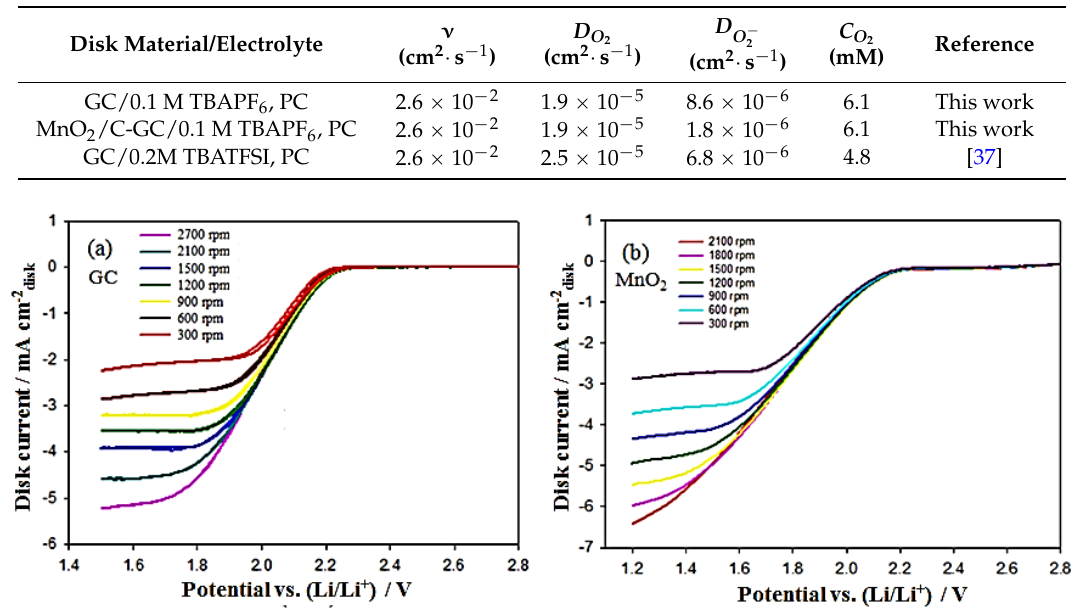
Figure 6. ( a ) Example of determination of the superoxide radical (O 2• − ) transit-time ( T s ) in O 2 -saturated solutions of 0.1 M TBAPF 6 in propylene carbonate (PC) at ω = 100 rpm, E disk = 1.85 V and E ring = 2.6 V. Transit time ( Ts ) values at different rotation rates for the diffusion of ( b ) O 2 and ( c ) O 2• − ; ( d ) relation between the inverse of the rotation speed and the transient time for O 2 and O 2• − . Table 1. Summary of the electrolyte properties estimated with the proposed RRDE-based methodology and comparison with findings reported in the literature.